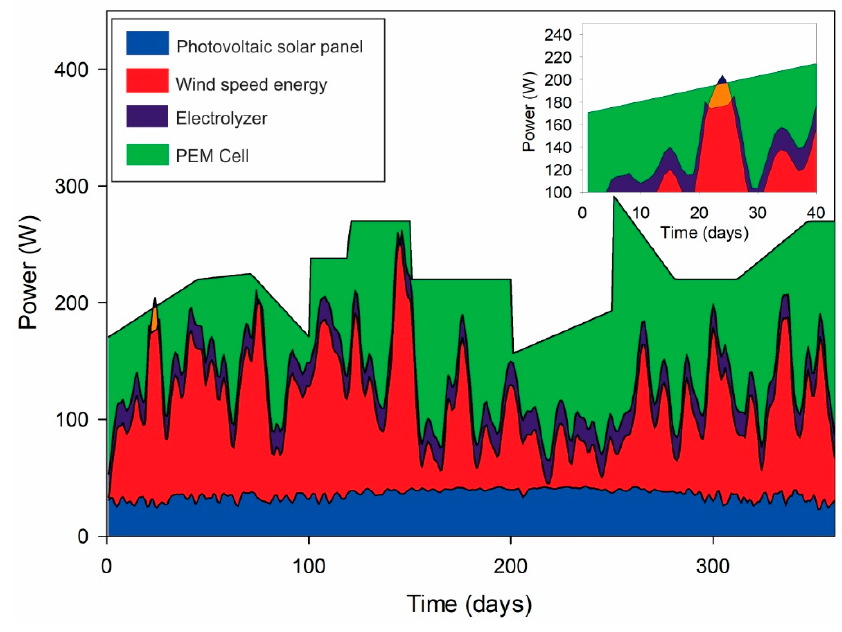
Figure A3. Power for Texas.